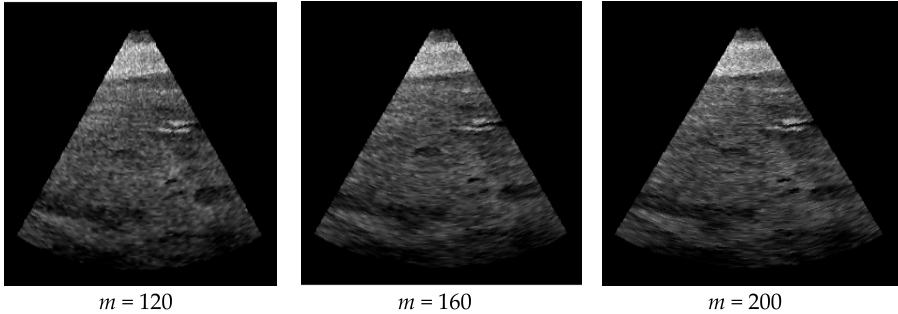
Figure 5. Effect of changing axial resolution ( m ) in radial–polar sampling ([13], reproduced with Effect of changing axial resolution ( m ) in radial-polar sampling ([13], reproduced permission). with